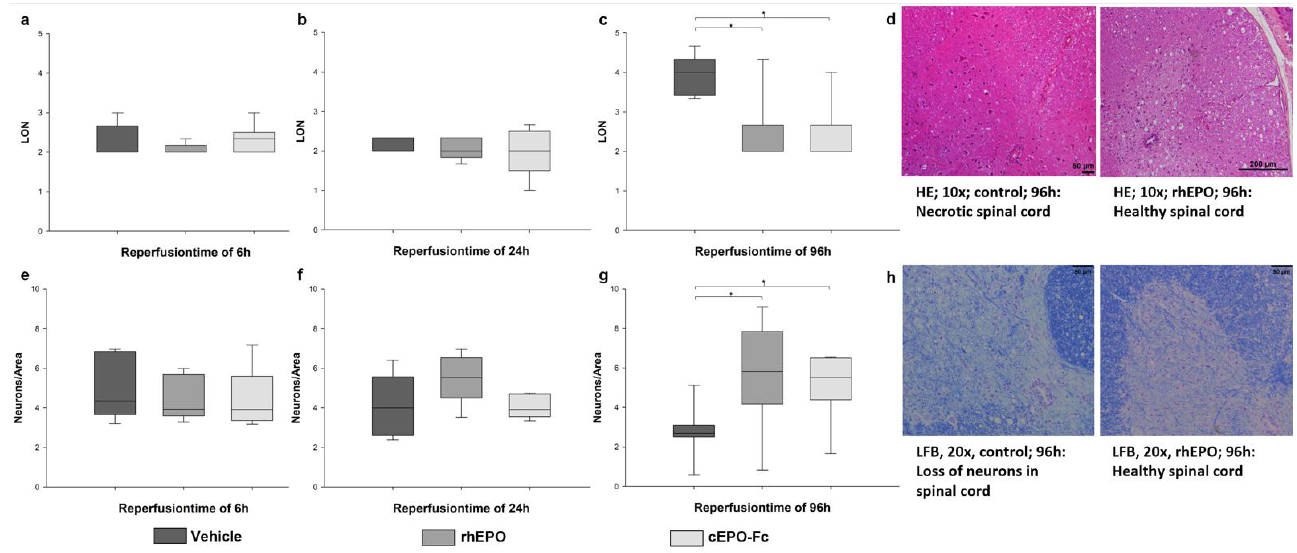
Figure 1. The results of the histopathology. The control group is in dark grey, the rhEPO group is in semi-dark grey, and the cEPO-Fc group is in light grey. Boxes indicate the upper and lower quartile, the line indicates the median, and the upper and lower whiskers indicate 2.5%- and 97.5% quantile. ( a ): Results of the scoring of the level of necrosis (LON) in the hematoxylin eosin (HE) staining after 6 h (h) of reperfusion time (RT). ( b ): LON in HE after 24 h RT. ( c ): LON in HE after 96 h RT. * p < 0.05 (Multiple group comparison via Kruskal–Wallis test and post hoc analysis using Dunn’s test). ( d ): HE in 10×. Necrotic spinal cord in the control group and healthy spinal cord in the rhEPO group after 96 h RT. ( e ): Results of the counting of the neurons/area (N/A) in the ventral horn of the spinal cord after 6 h RT. ( f ): N/A in the ventral horn of the spinal cord after 24 h RT. ( g ): N/A in the ventral horn of the spinal cord after 96 h RT * p < 0.05 (Multiple group comparison via Brown – Forsythe test and post hoc analysis using Bonferroni test). ( h ): LFB in 20×. Loss of neurons in the control group healthy spinal cord in rhEPO group after 96 h RT.